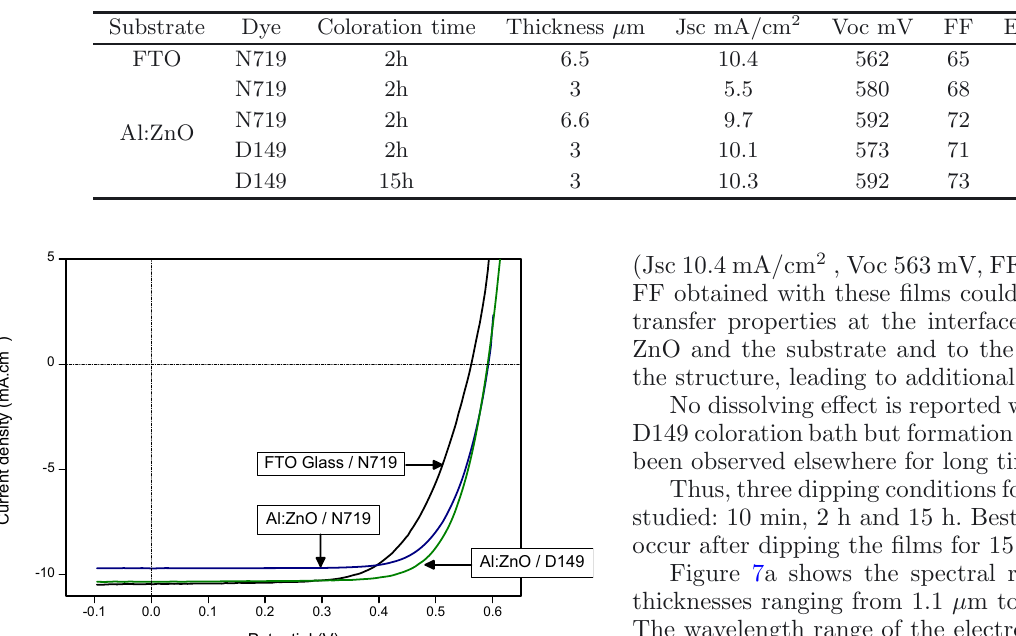
Table 1. Photovoltaic properties of dye sensitized solar cells based on ZnO electrodeposited on different substrates and for different coloration conditions.